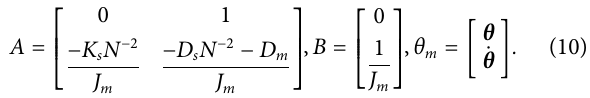
Frontiers in Robotics and AI |